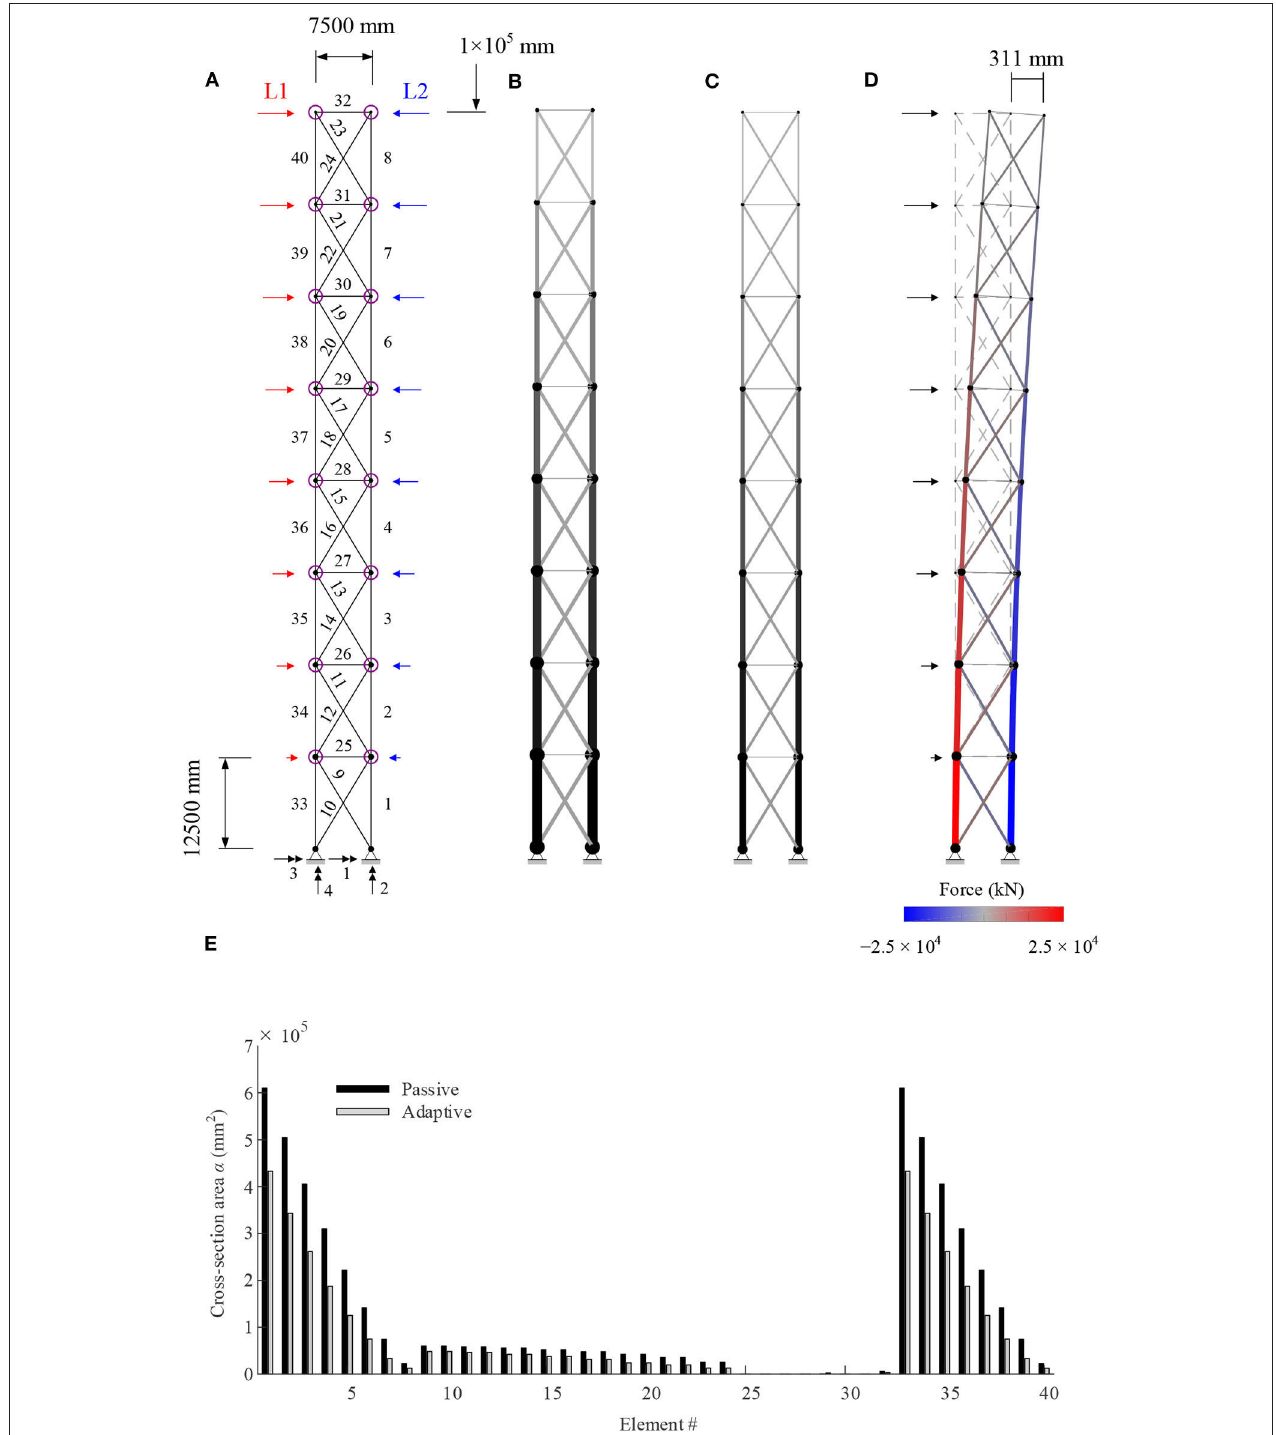
FIGURE 2 | Multi-story building: (A) dimensions, controlled nodes, and loading; (B) passive; (C) adaptive ( MUT 28%); (D) deformed shape and element forces of the adaptive solution under LC1 before control (magnification × 20); (E) element cross-section area passive vs. adaptive. for both passive and adaptive solutions are also indicated by indicates the element diameter while the cross-section area is the bar chart shown in Figure 2E . With regard to the adaptive represented through a color gradient whereby a larger area is solution, elements #1, #33 and #25 have the largest and smallest assigned a darker gray shade. The element cross-section area